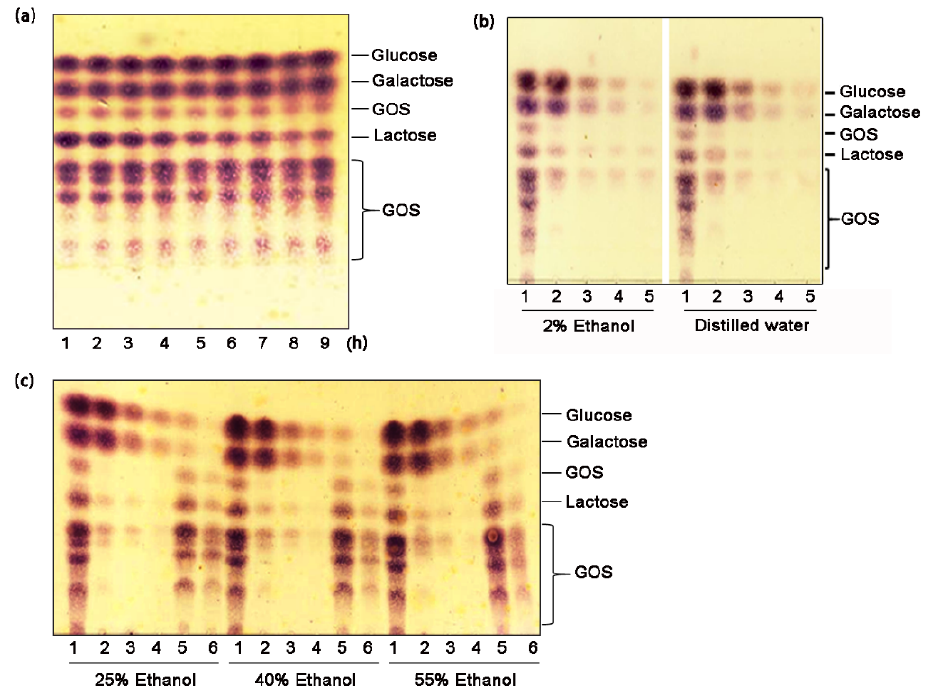
Figure 4. Processes of GOS synthesis and purification. ( a ) GOS synthesis by L. bulgaricus L3 β -galactosidase within 9 h. ( b ) Elution of monosaccharides from activated charcoal particles. 1, GOS products; 2, samples after charcoal adsorption; 3–5, sequential elution of monosaccharides by 2% ethanol (left) or distilled water (right). ( c ) GOS purification by activated charcoal adsorption. 1, GOS products; 2, samples after adsorption; 3 and 4, sequential elution of monosaccharides by distilled water; 5 and 6, sequential elution of oligosaccharides by high concentrations of ethanol.